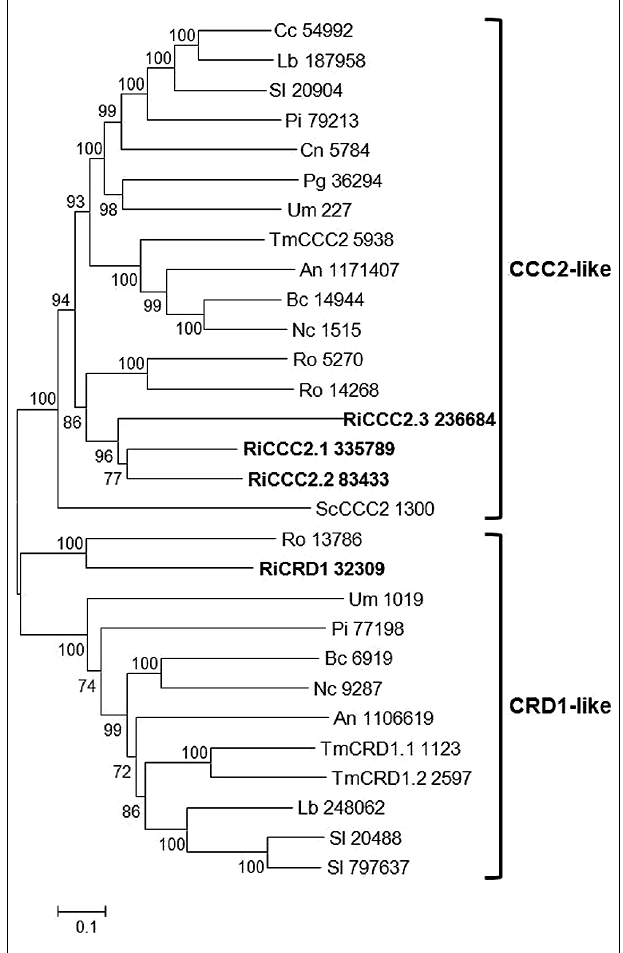
FIGURE 3 | Phylogenetic relationships of the Rhizophagus irregularis copper-transporting P-typeATPases (CCC2) with homologous sequences from selected species representative of the major fungal phyla. The Neighbor-Joining tree was created with MEGA 6. Protein JGI identification numbers are indicated. R. irregularis genes are shown in bold. Organisms: An, Aspergillus niger ; Bc, Botrytis cinerea ; Cc, Coprinopsis cinerea ; Cn, Cryptococcus neoformans ; Lb, Laccaria bicolor ; Nc, Neurospora crassa ; Pi, Piriformospora indica ; Pg, Puccinia graminis ; Sc,